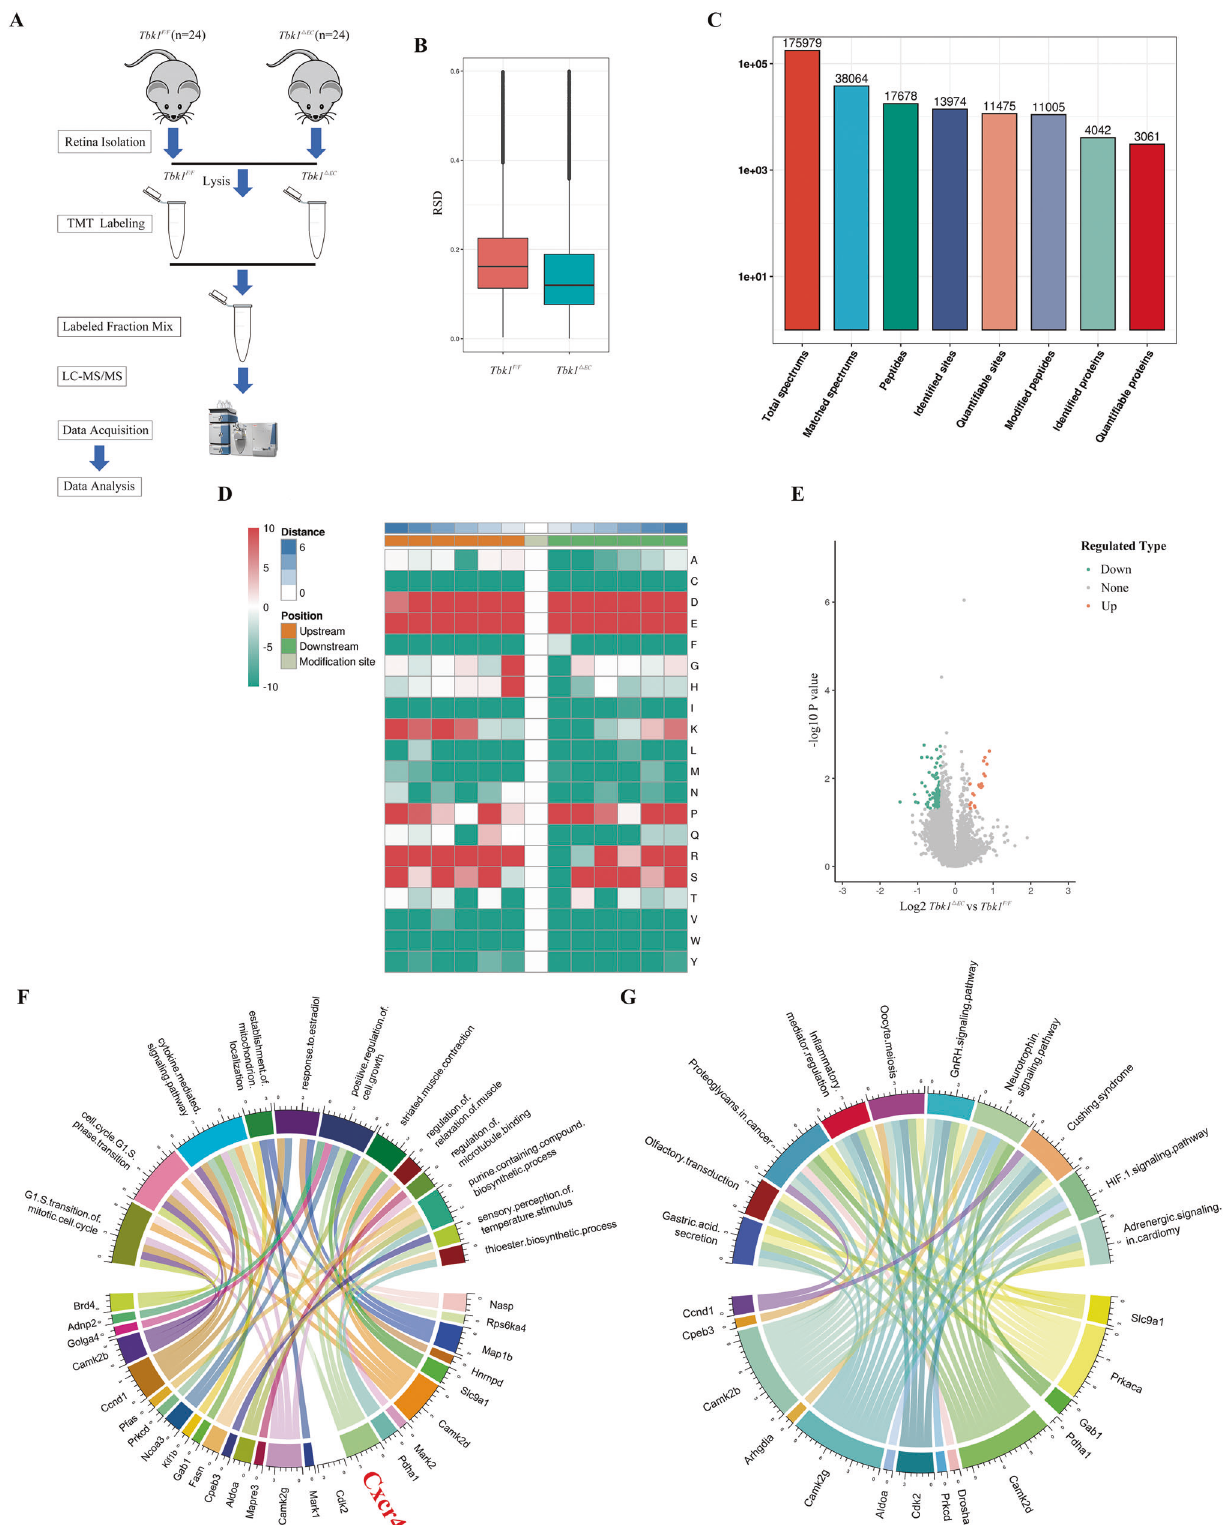
Fig. 3 Overview of the phosphoproteomic analysis in Tbk1 F/F and Tbk1 Δ EC retinas. A Schematic outline of the work fl ow for quantitative phosphoproteomic analysis. B Relative standard deviation (RSD) for the Tbk1 F/F and Tbk1 Δ EC groups. C Numbers of the identi fi ed phosphopeptides and phosphorylated sites. D Motif analysis of the phosphopeptides with modi fi ed serine at position 0. E Volcano plot of phosphopeptide reporter ion intensity ratio ( Tbk1 Δ EC vs Tbk1 F/F ) vs p value. Colored dots represented phosphopeptides with highly signi fi cant differential intensities. Red dots: upregulated; Green dots: downregulated. F GO Clustering analysis of proteins with different phosphorylation levels in the Tbk1 Δ EC group vs Tbk1 F/F group. G KEGG Clustering analysis of proteins with different phosphorylation levels in Tbk1 Δ EC group vs Tbk1 F/F group. Cell Death Discovery (2022)